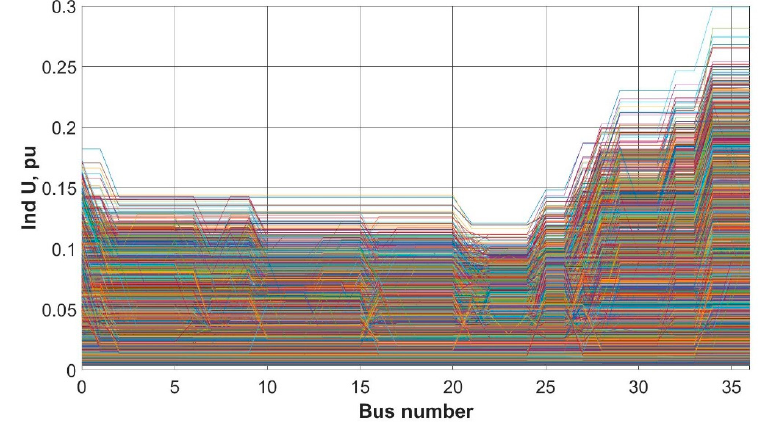
Figure 15. The results of the simulation assessment of the voltage quality indicator Ind U for the IEEE 37 network depending on the selection of the reference node, the voltage of which is maintained at a given level by the OLTC controller.